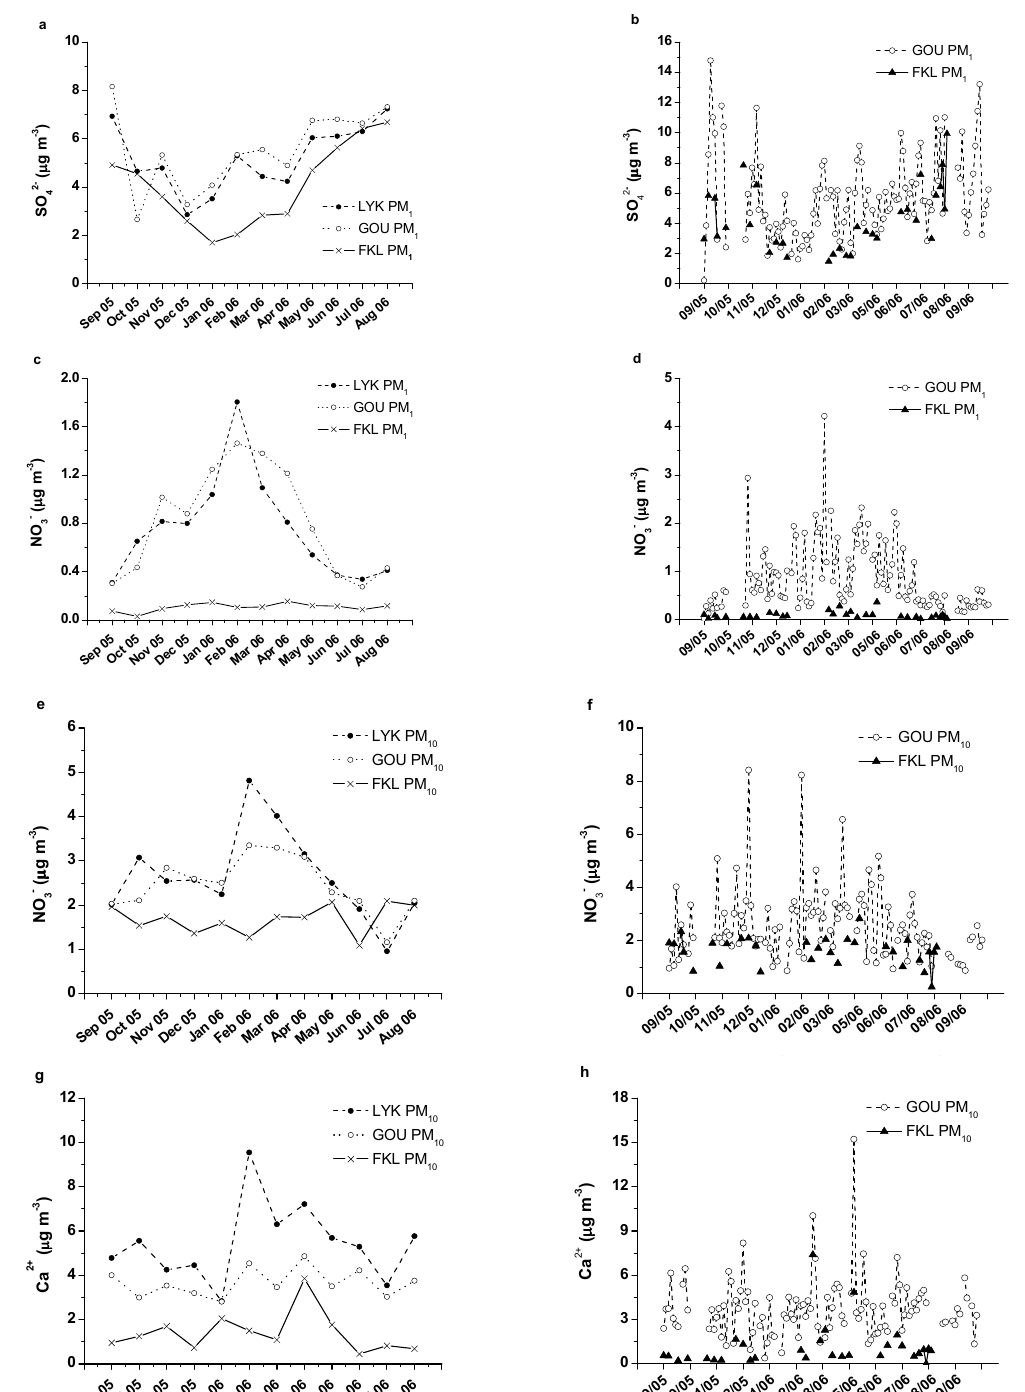
Fig. 8. Seasonal (a, c, e, g, i, k and m) and daily (b, d, f, h, j, l and n) variations (µgm − 3 ) for SO 2 − and for NO − and Na + in PM 10 3